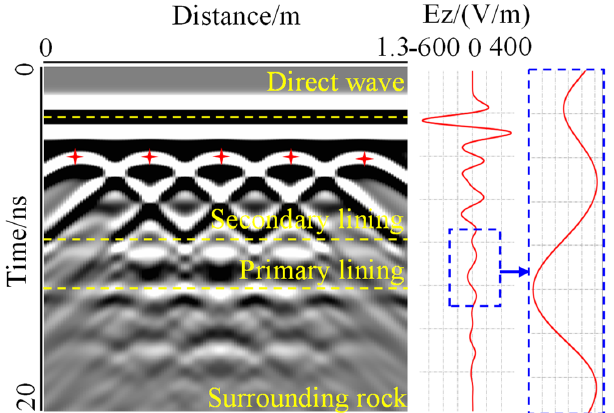
Figure 8. Forward image of support B. The steel bars caused the strong reflection and diffraction of electromagnetic waves, which covered the reflected signals from interface Ⅰ and Ⅱ .